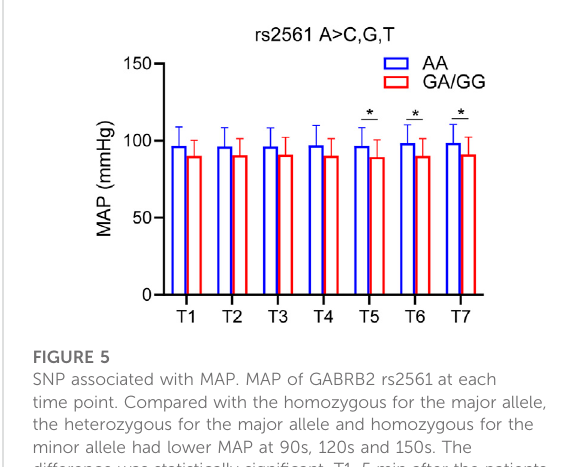
FIGURE 5 SNP associated with MAP. MAP of GABRB2 rs2561 at each time point. Compared with the homozygous for the major allele, the heterozygous for the major allele and homozygous for the minor allele had lower MAP at 90s, 120s and 150s. The difference was statistically signi fi cant. T1, 5 min after the patients entered the room; T2, before the administration of etomidate; T3, 30 s; T4, 60 s; T5, 90 s; T6, 120 s; T7, 150 s after the etomidate. Two-way ANOVA was used as statistical analysis. * p <